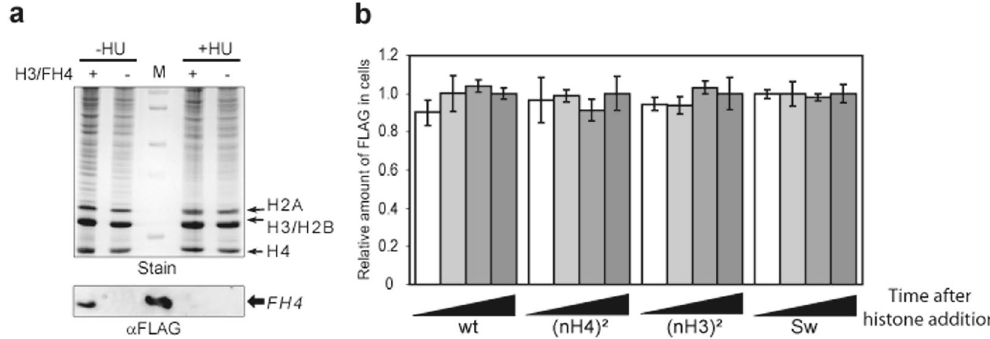
Figure 3. Exogenous histone complexes are stably incorporated into Physarum cells. ( a ) Hydroxy-urea treatment inhibits nuclear import. Cell fragments in early S-phase were untreted ( − ) and treated ( + ) with exogenous H3/FH4, and untreated ( − HU) and treated with hydroxyl-urea ( + HU), concomitantly. Nuclei were prepared and analyzed by SDS-PAGE (Stain) and Western blotting ( α FLAG). Lane M corresponds to the molecular weight marker in (Stain) and the purified H3/FH4 complex revealed by anti-FLAG antibody in ( α FLAG). ( b ) Determination of the stability of exogenous histone complexes in Physarum . Cell fragments were treated with HU and exogenous complexes were incorporated for 15 min, 30 min, 45 min and 60 min, respectively. Shown is the quantitative analysis of Flag signal relative to the amount of total soluble proteins determined by dot blotting. The quantification at time point 60 min was arbitrary assigned to 1.0 for each complex. Note that signals of untreated cell fragments with exogenous histones were ~10%. ( c ) Exogenous histone complexes are transported in nuclei with similar rates. The different histone complexes were spread onto Physarum surfaces and harvested after 20 min, 40 min and 60 min, respectively. Nuclei were then prepared and analyzed by Western blotting. Shown is the amount of exogenous histone complexes in the nuclear fractions at specific incorporation duration. The value 1 for each complex corresponded to the incorporation after 60 min.